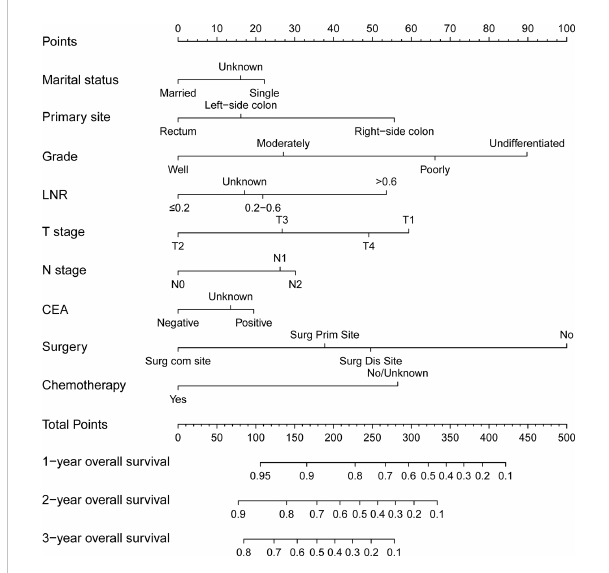
FIGURE 2 A nomogram for predicting 1-, 2- and 3-year overall survival of patients with young-onset colorectal cancer with synchronous liver- only